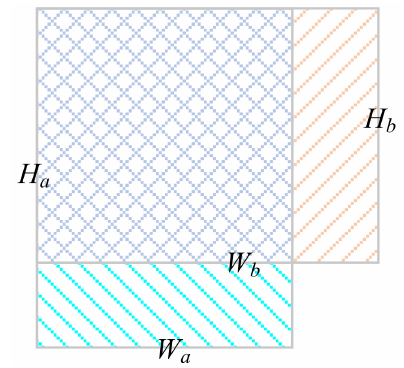
Figure 7. Calculation of